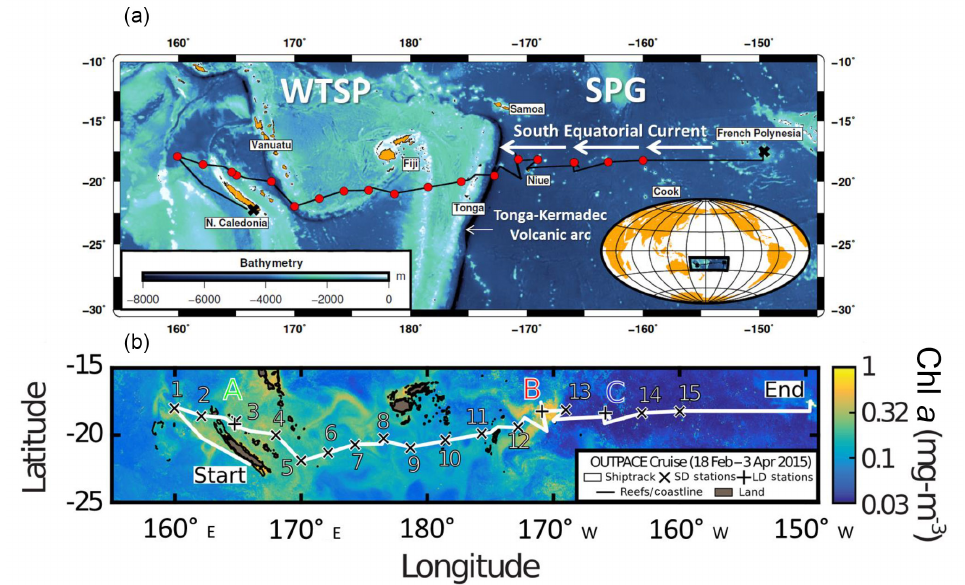
Figure 1. (a) Map of the western and central Pacific and associated seas (courtesy T. Wagener and A. De Verneil). (b) Sampling locations superimposed on composite sea surface Chl a concentrations during the OUTPACE cruise (19 February–3 April, quasi-Lagrangian weighted mean Chl a ). Short-duration (X) and long-duration ( + ) stations are indicated. The satellite data are weighted in time by each pixel’s distance from the ship’s average daily position for the entire cruise. The white line shows the vessel route (data from the hull-mounted ADCP positioning system; courtesy A. De